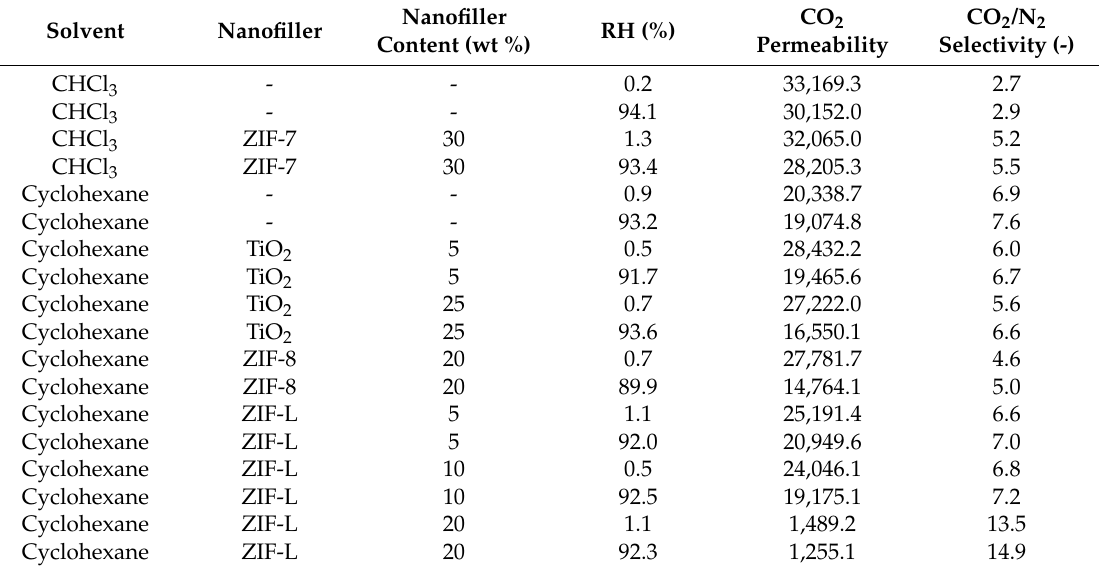
Table 2. Summary of PTMSP hybrid membrane separation